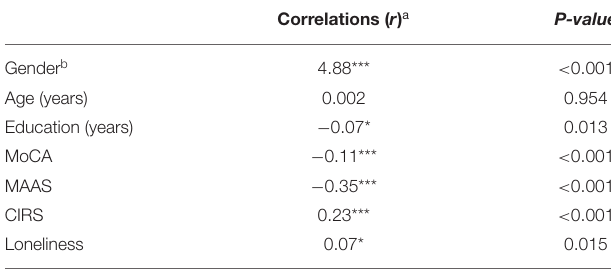
TABLE 2 | Clinical correlates of CIS-R